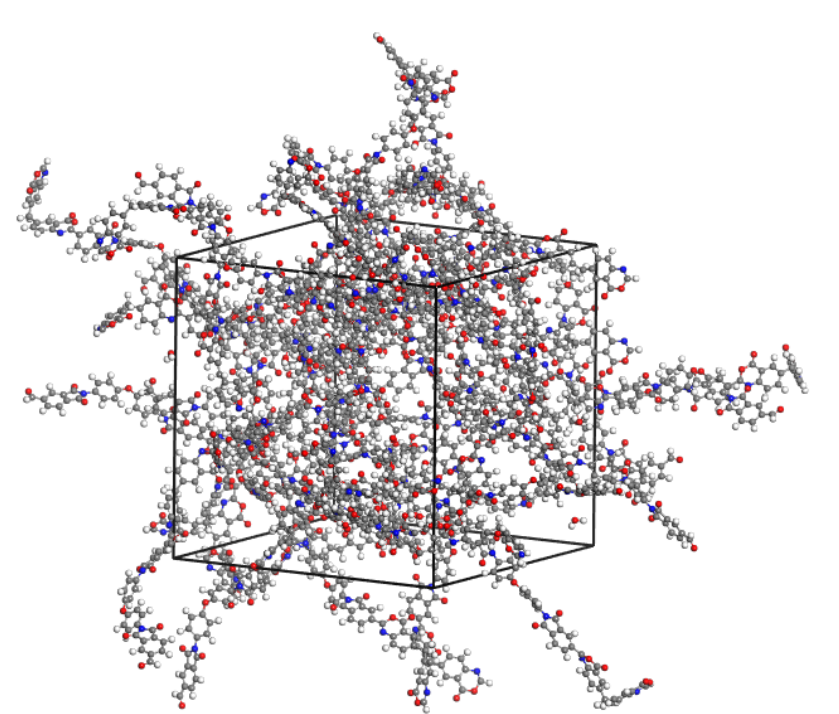
Figure 3. Cell for the system PBOI-water used for MD simulation. Calculations of the mobility of penetrant molecules were estimated by the values of the root-mean-square displacements (MSD) Figures 4–7 presented in Table 3.